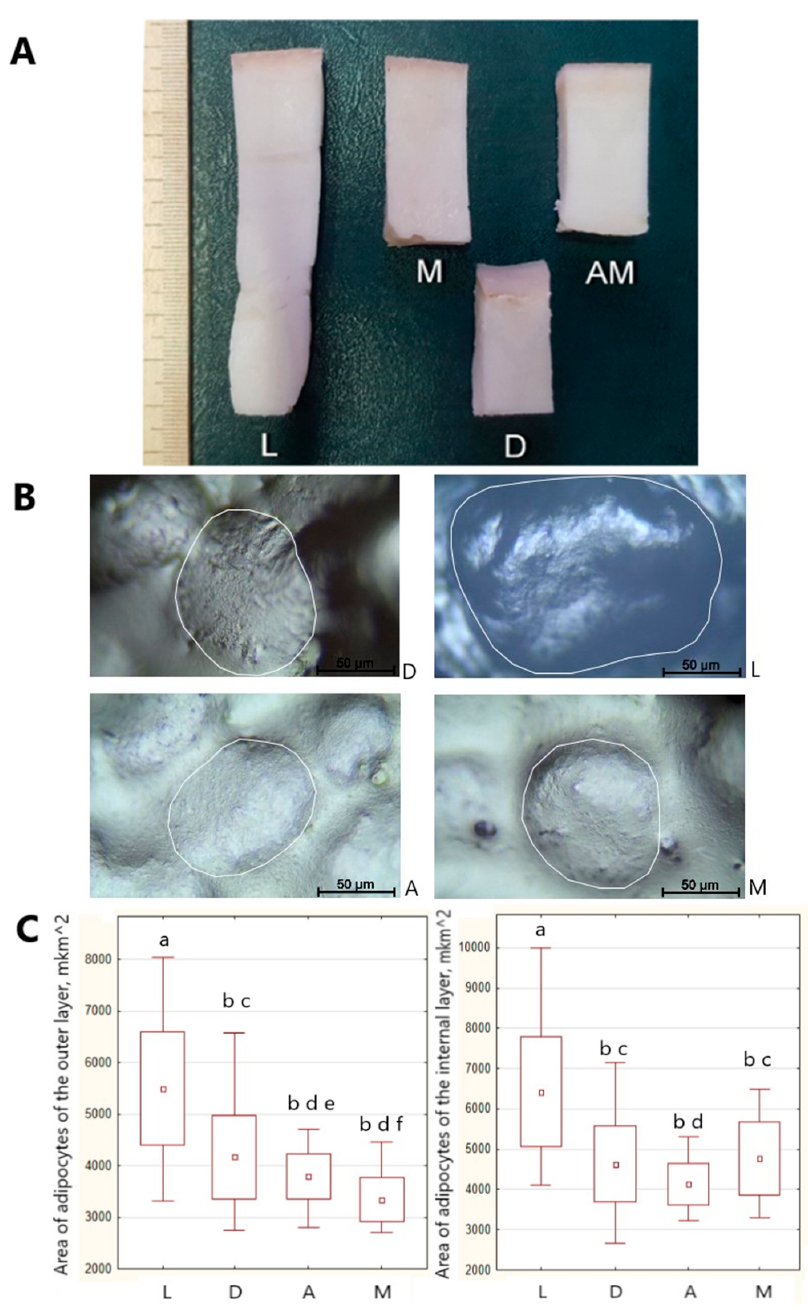
Figure 2. Backfat depending on pig breed: ( A ) The thickness of the backfat; ( B ) Histomorphological traits of backfat; ( C ) The area of adipocytes in different layers of the backfat: Data presented as box plots illustrate hinges extending from the mean ± SD, the mean point within the box and whiskers extending to the minimum and maximum values of the dataset. Note: a–f—Different letters indicate statistically significant differences ( p ≤ 0.05).